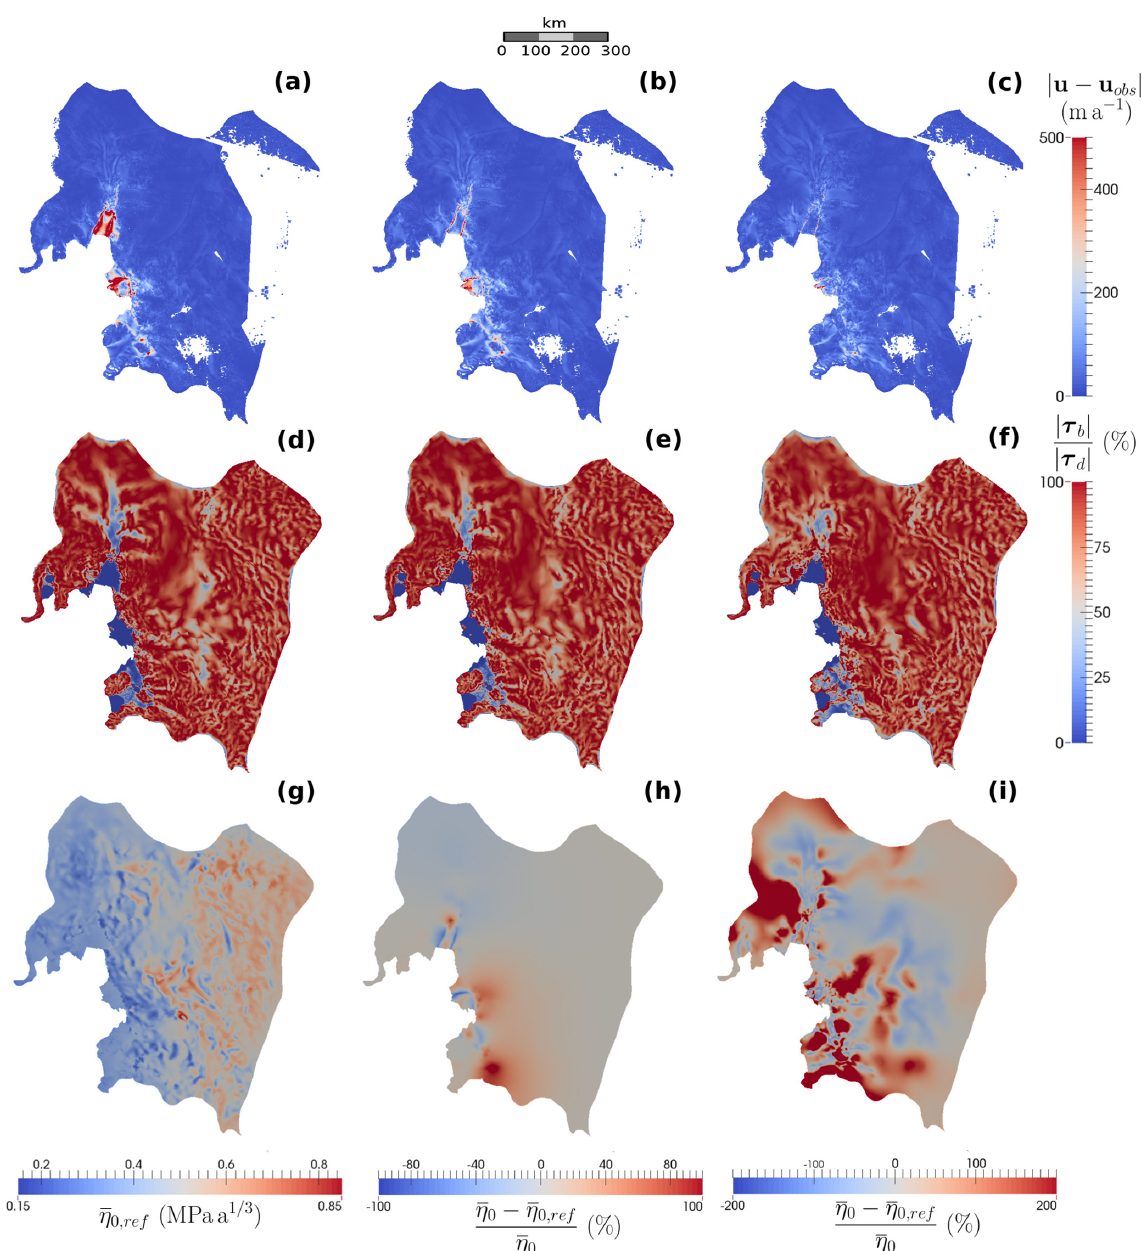
Figure 4. Comparison of inferred states I R (first column), I R (second column) and I R (third column). For each of the three inferred γ, ∞ γ, 100 γ, 1 states, the first row – panels (a) , (b) and (c) – shows the absolute difference between modelled u and observed u obs velocities (ma − 1 ); the second row – panels (d) , (e) and (f) – shows the ratio of the norm of τ b relatively to the norm of τ d ; the third row shows the reference field η 0 , ref (MPaa 1 / 3 ) for the inferred state I R – panel (g) – as well as the relative difference between η 0 and η 0 , ref for the inferred states γ, ∞ I R (second column) and I R – panels (h) and (i) . Note the different colour scales for panels (h) and (i) γ, 100 γ, 1